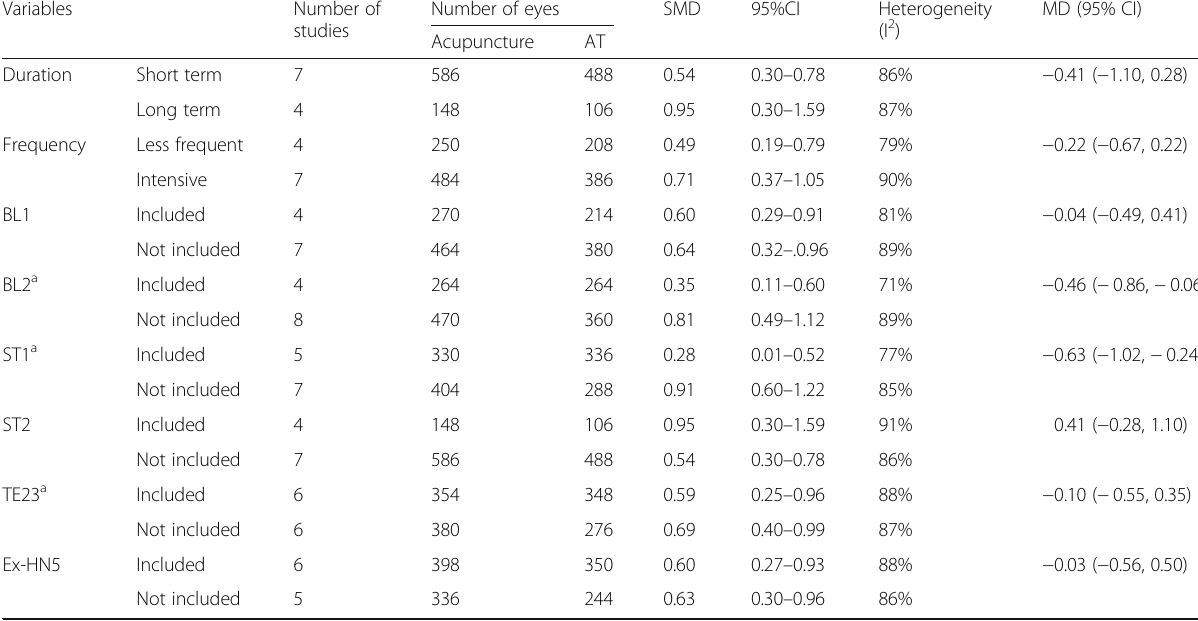
Table 3 Results of subgroup analysis by treatment duration, frequency, and specific acupoints